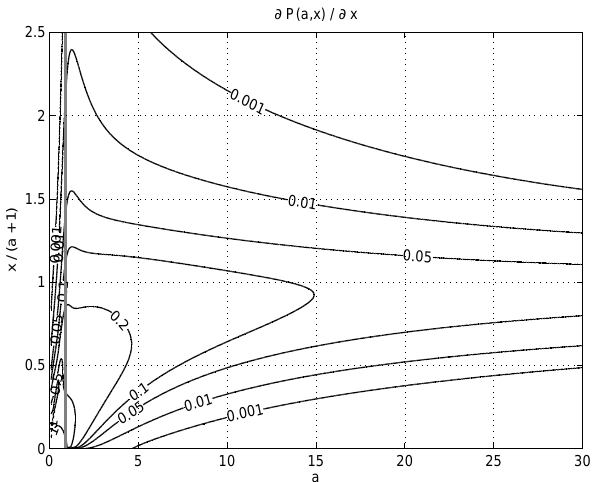
Fig. 5. ∂ ˆ P(a,x)/∂x = 1 /0(a)∂ ˆ γ l (a,x)/∂x as function of a and x/(a + 1 ) . Same scaling of x and same grey line as in Fig. ∂ ˆ P ( a,x ) /∂x =1 / Γ( a ) ∂ ˆ γ l ( a,x ) /∂x as function of a and x/ ( a +1) . Same scaling of x and same Fig. 5. grey line as in Fig. 4.